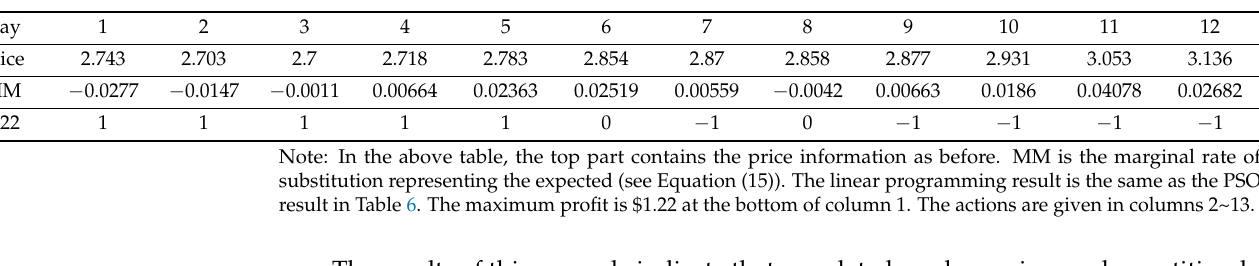
Table 7. The slight difference could be due to a Monte Carlo error. Table 7. LP